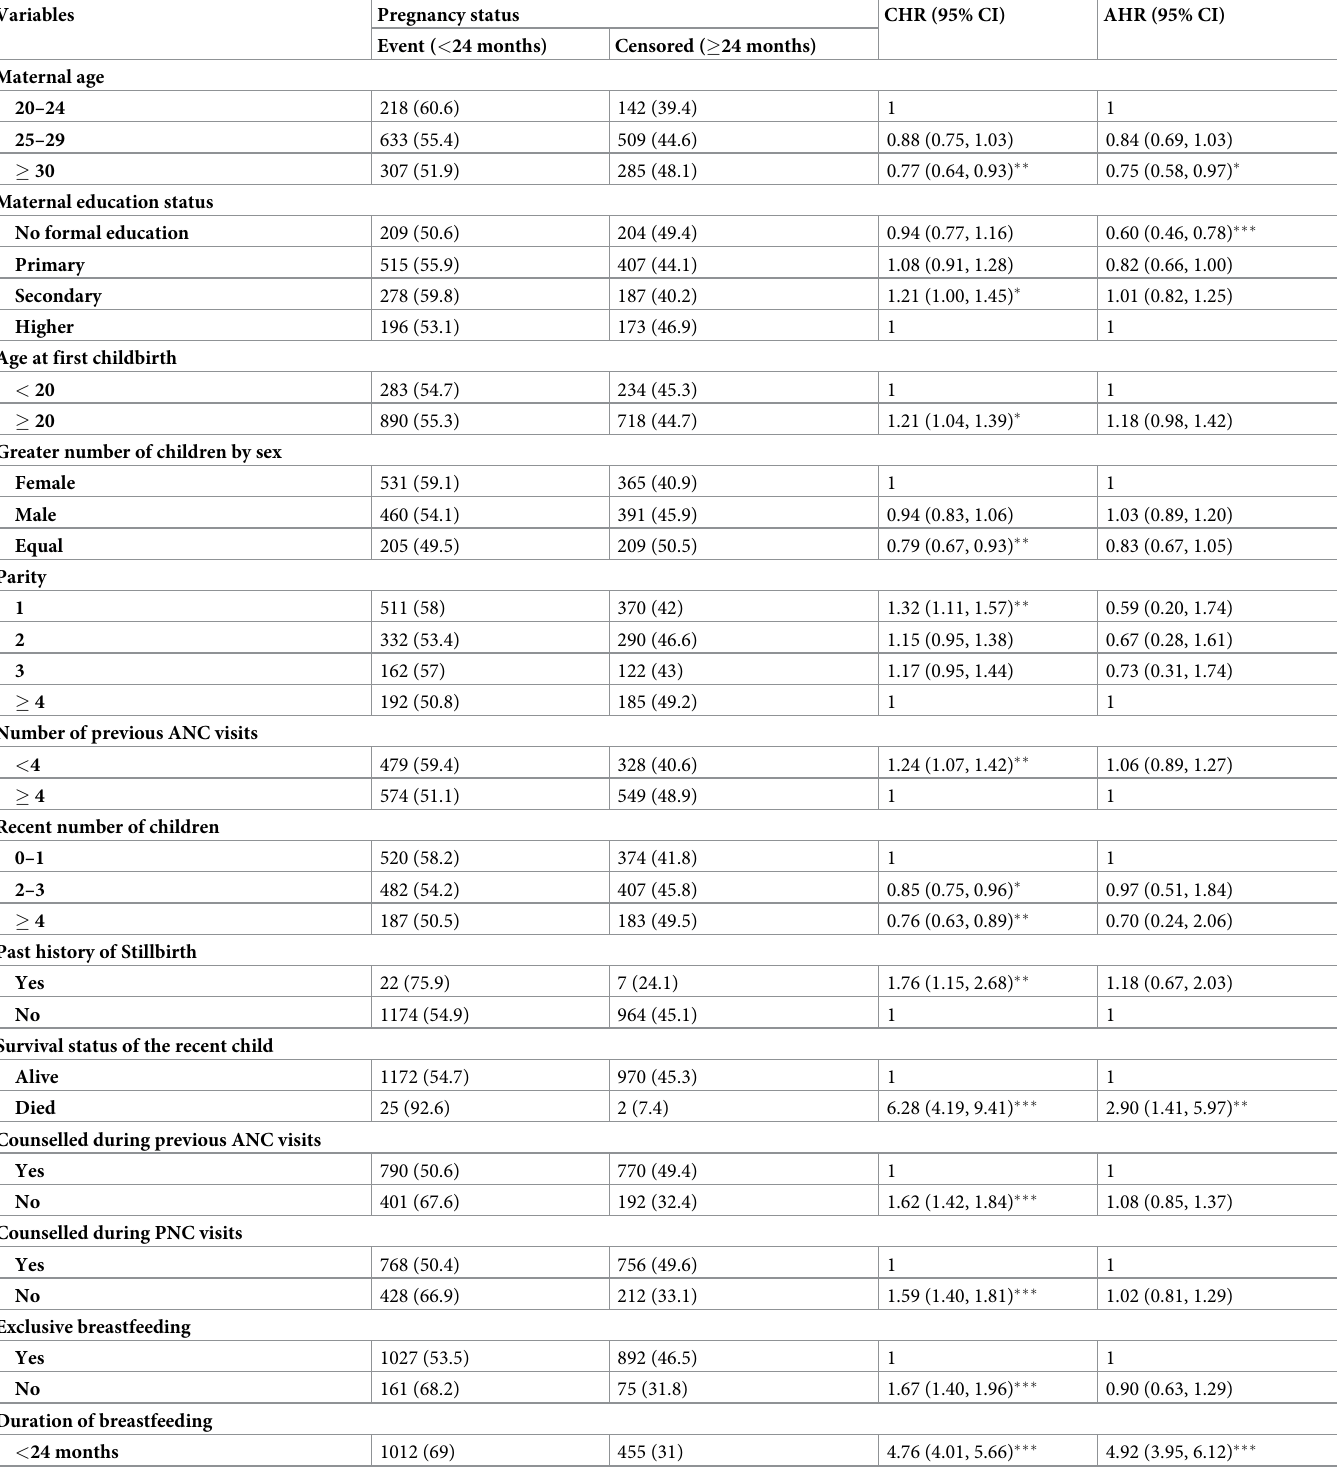
Table 3. Multivariable Cox gamma shared frailty analysis for the predictors of short inter-pregnancy interval among pregnant women in urban South Ethiopia,